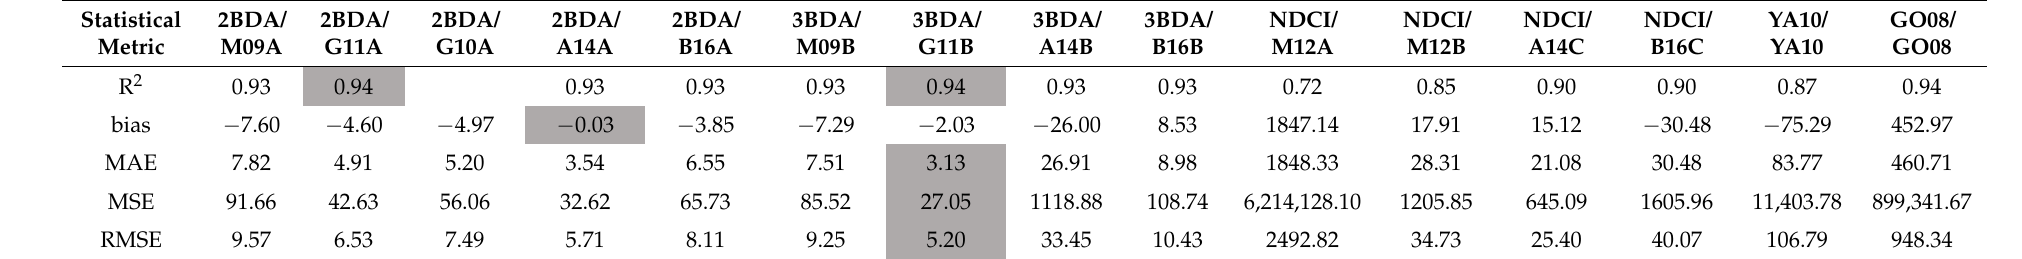
Table A3. Statistical metrics (R 2 , bias, MAE, MSE, RMSE) for different chl- a bio-optical algorithms from Sentinel-2 / MSI image for Müritz-Havel Lakes. 3BDA with G10B calibration and GO08 with GO08 calibration did not produce results. Shaded cells indicate the best values of each metric.